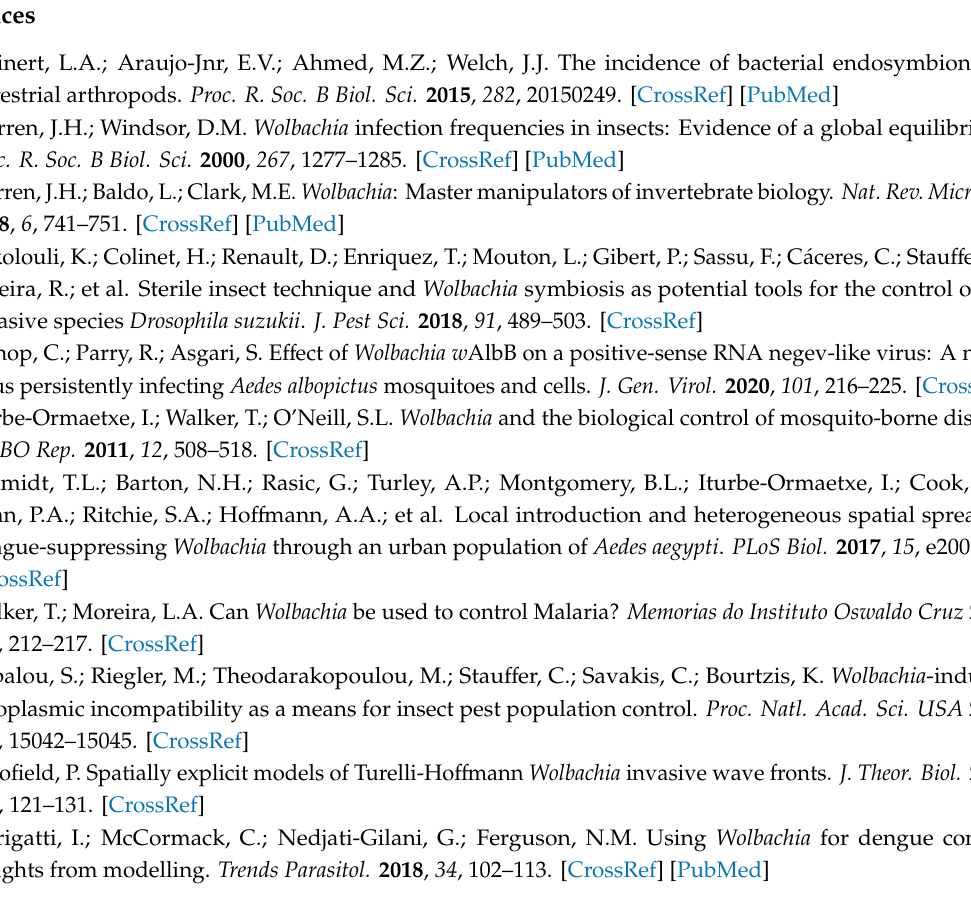
Table S1: Method used for mitochondrial haplotype determination for each Rhagoletis cerasi individual accompanied by the Sanger sequence where applicable; Figure S1: Electrophoresis gel showing an example of HT1 and HT2 digestion with restriction enzyme HaeIII